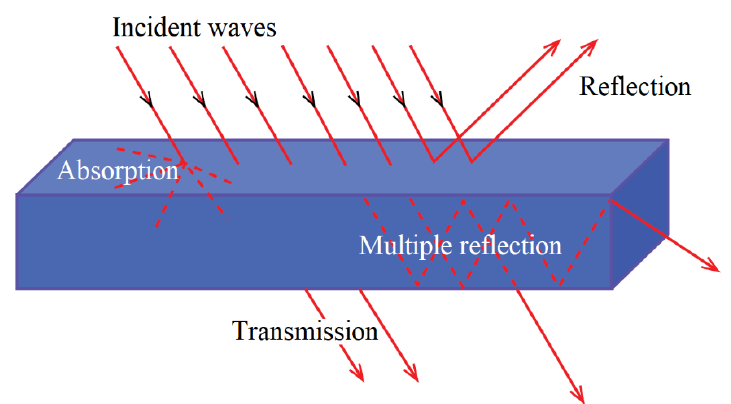
Figure 1. Schematic representation showing the mechanism of electromagnetic shielding. Reproduced with permission from Ajay et al. [48], Copyright 2018, John Wiley and